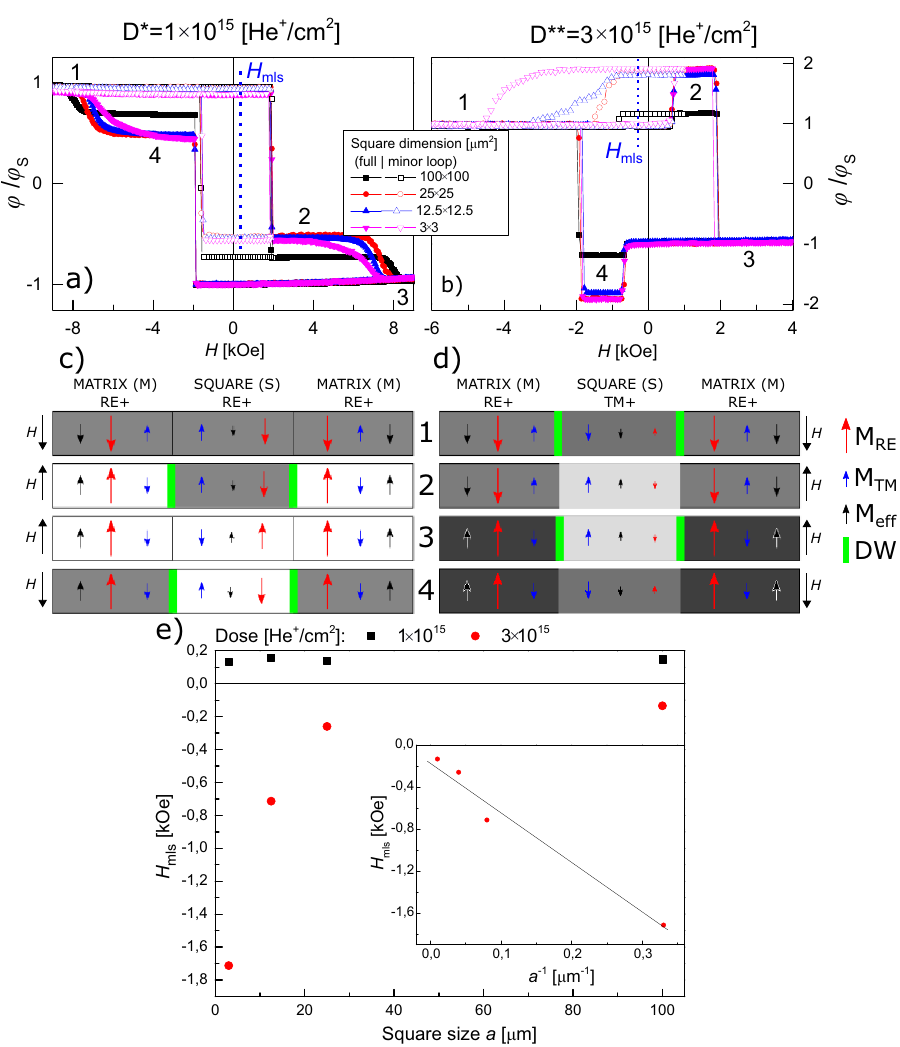
Figure 3. Full and minor hysteresis loops of sample B1, obtained using a Kerr magnetometry in polar configuration, for a 2D lattice of squares with different sizes and patterned with two different doses, ( a ) D* = 1 × 10 15 He + /cm 2 and ( b ) D** = 3 × 10 15 He + /cm 2 , H mls – indicates the shift of the minor hysteresis loop for a lattice with square sizes of 25 × 25μm 2 . Magnetization orientations of the matrix and the squares for ion beam patterning with D * ( c ) and D ** ( d ). The black, blue and red arrows correspond to effective magnetization, magnetization of Co and of Tb subsystems, respectively. The shades of gray correspond to the differential images presented in Figs. 4–9. ( e ) Minor loop shift as a function of square size [ H mls (a)], inset H mls